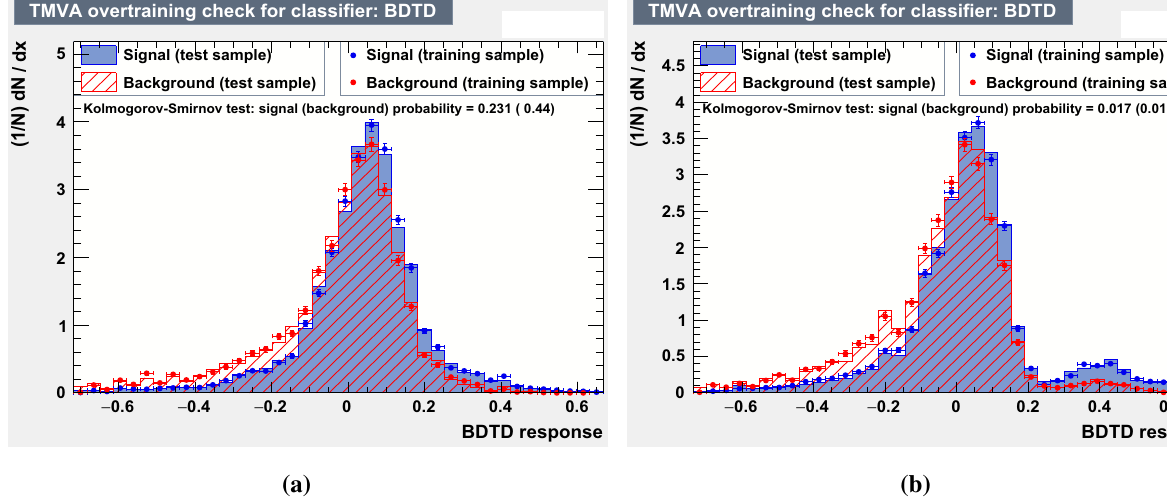
Fig. 8 KS-scores corresponding to a BP1 and b BP3 for 2 (cid:3) + E T / channel